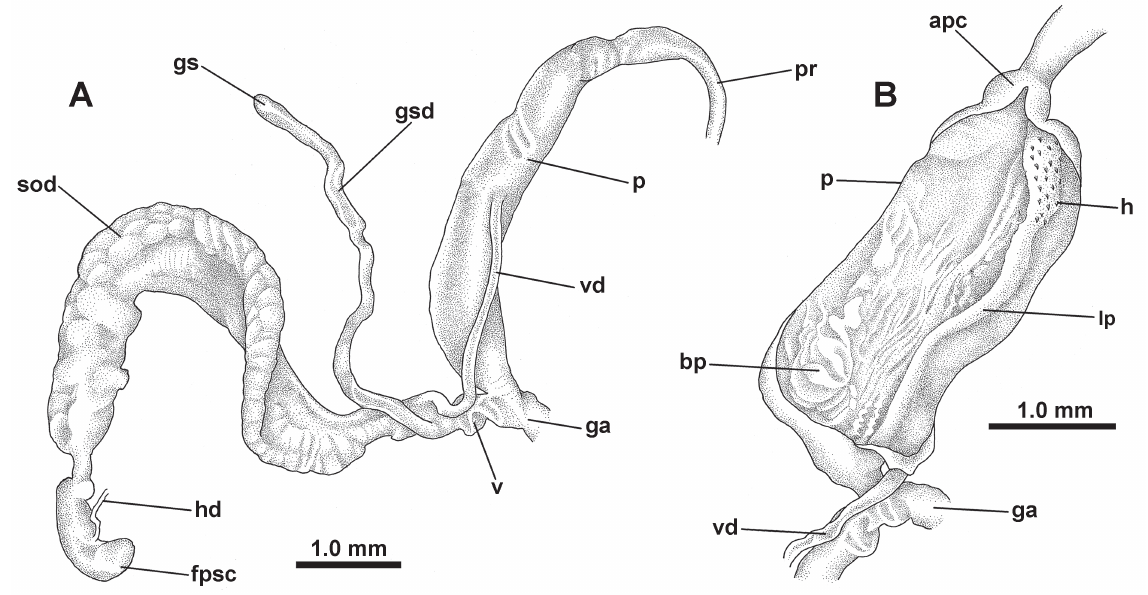
Fig. 2. Gulella davisae sp. nov., genitalia, paratype (NMSA P0269/T4090). A . Distal portion of genital system. B . Internal structure of